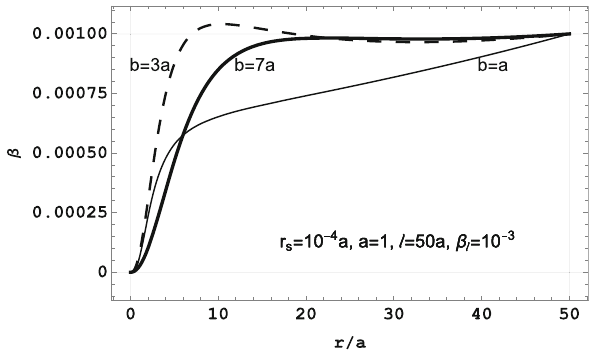
Fig. 4 Self consistent equilibrium of an hypothetical dust distribution described by the Miyamoto-Nagai potential-density